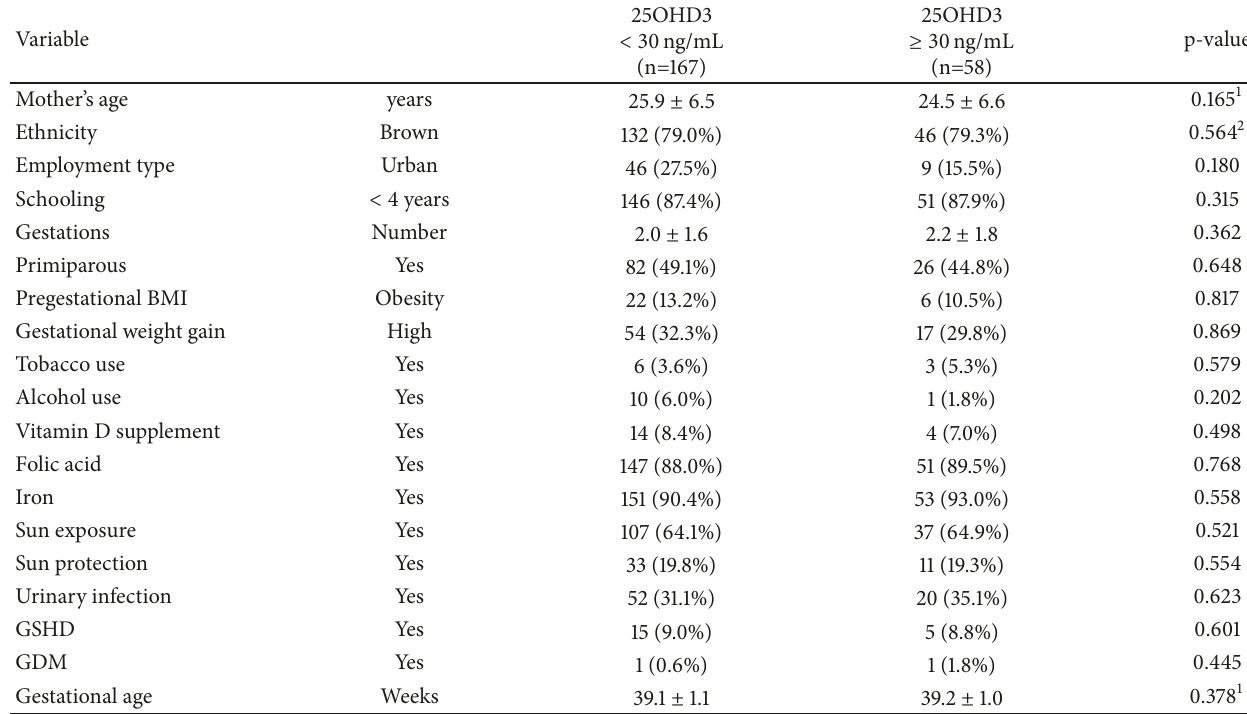
Table 2: Comparison of conditions during gestation with vitamin D concentrations in women